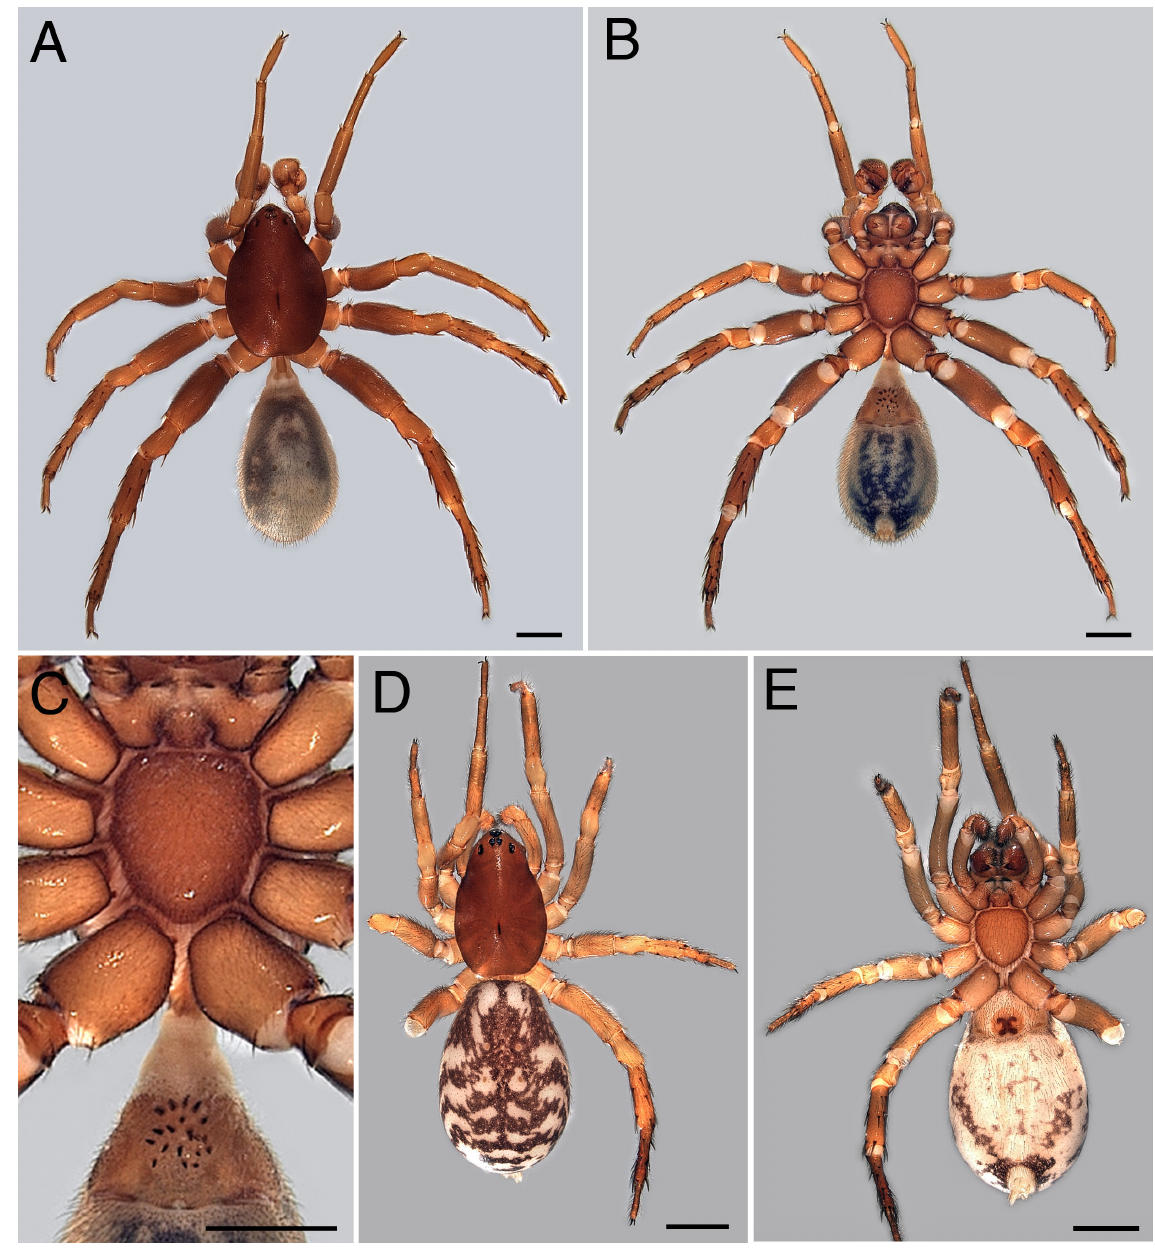
Fig. 11. Ballomma neethlingi gen. et sp. nov. A–C . Paratype, ♂ (NCA 76/1048) D–E . Holotype, ♀. A . Habitus, dorsal view. B . As preceding, ventral view. C . As preceding, detail. D . Habitus, dorsal view. E . As preceding, ventral view. Scale bars: 1